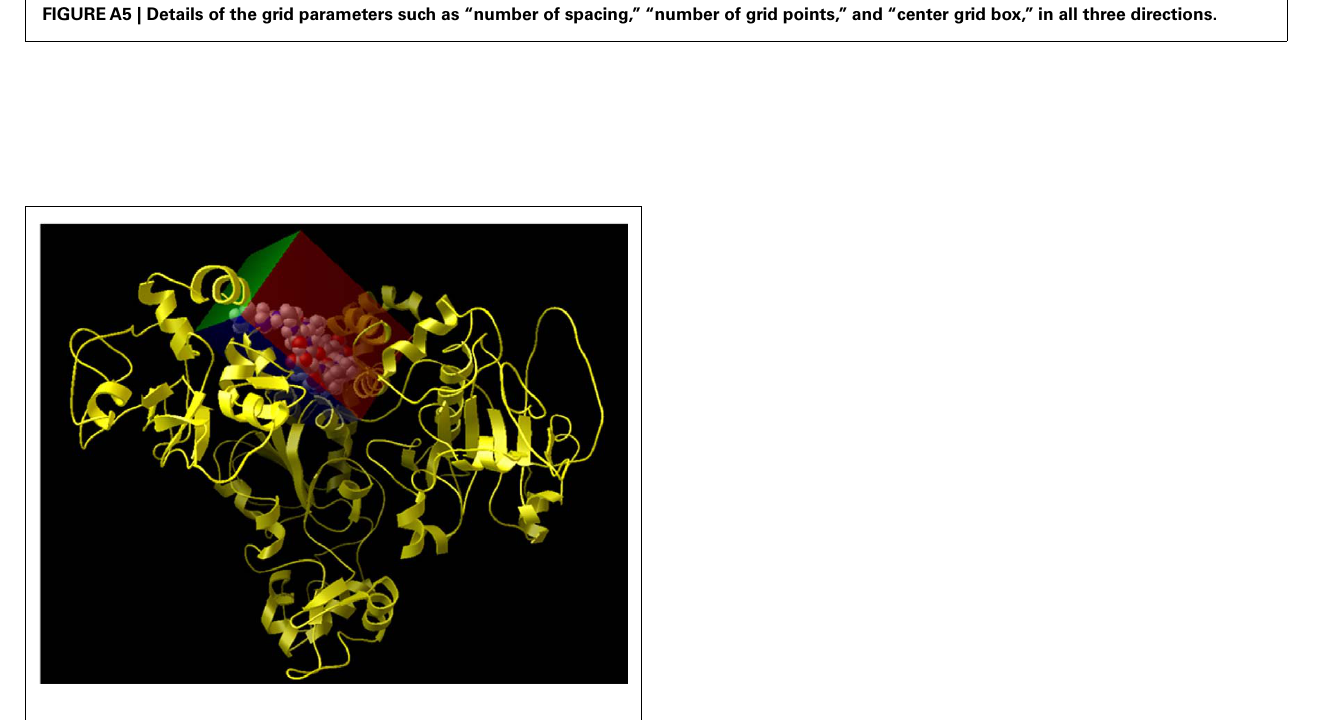
FIGUREA6 | Representation of the grid box created on the surface of Sirt-1 around the allosteric site. In details, Sirt-1 is reported in yellow cartoon conformation and the area of active site in the cpk